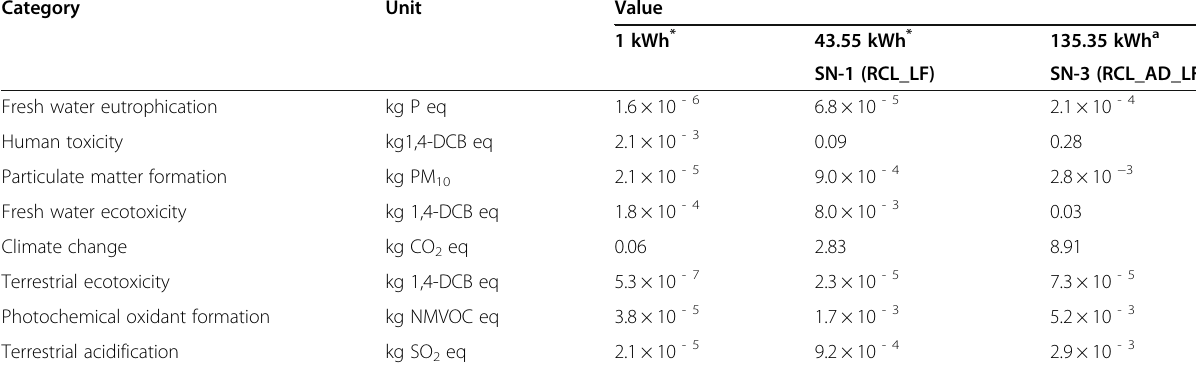
Table 5 Environmental impacts from the production of hydropower electricity (Ecoinvent v.3.6 database) Category